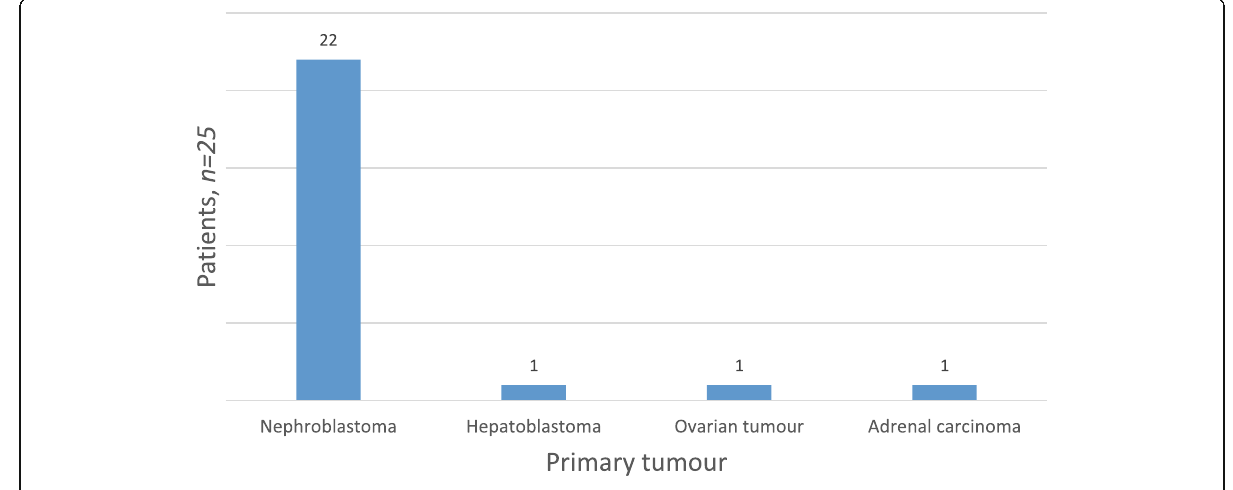
Fig. 1 Primary tumour of study patients who underwent thoracoscopic lung